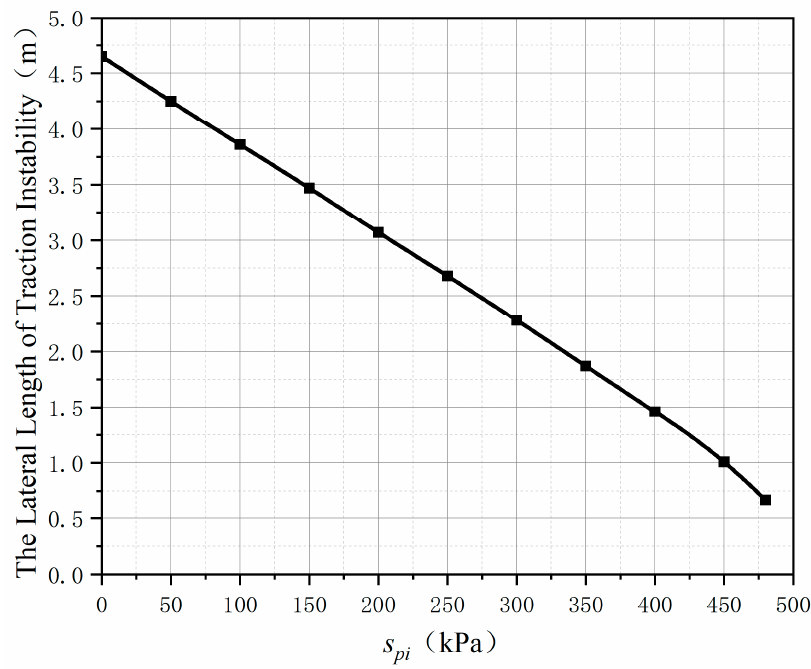
Figure 14. Influence of S pi on the lateral length of traction instability.